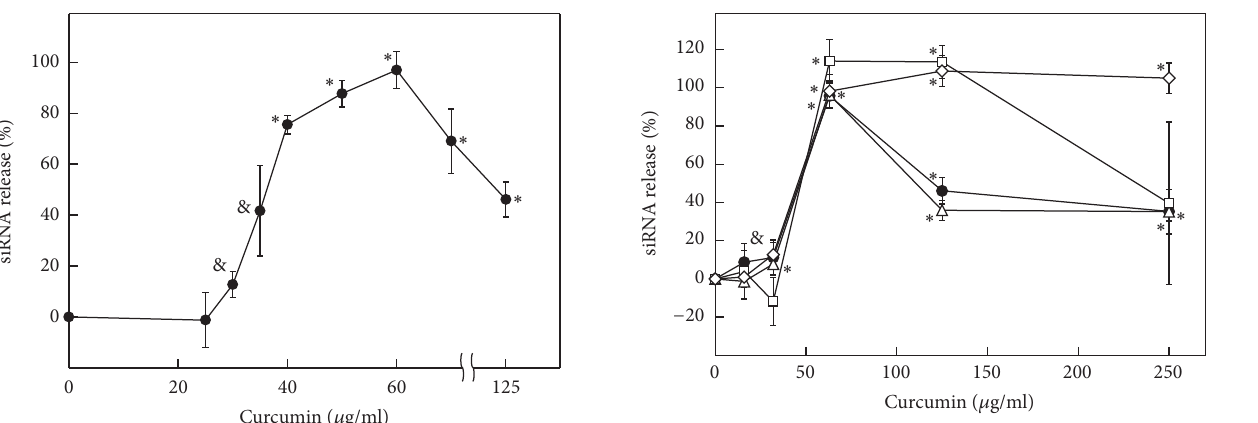
Figure 2: Bell-shaped dose-response in the release of siRNA from DOPC/DOPE liposomes induced by curcumin.DOPC/DOPE liposomes containing siRNA were treated with curcumin at 25 to 125mg/ml, and then agarose gel electrophoresis was done in the same manner as Figure 1. The amount of released siRNA was determined from photographic images of EtBr-stained agarose gels by using commercial software. Assays were done in triplicate and data were represented as mean values ( e ) and standard errors (vertical bars). Percentages of siRNA release were expressed as relative values with Triton X-100-treated samples defined as 100% and DMSO-treated samples as 0%. The results of Student’s 𝑡 -test in comparison of each sample treated with curcumin to control are expressed as 𝑝 values with symbols (&: < 0.05; ∗ : < 0.01) in the figure, respectively.